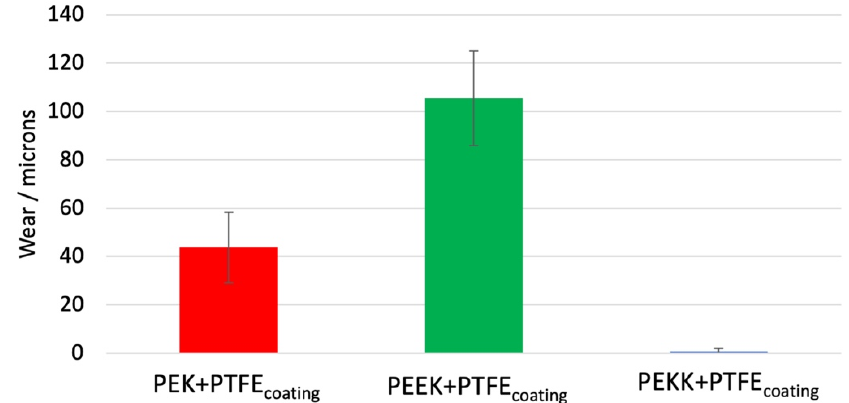
Figure 15. Combined final wear of the coatings tested in incremental load